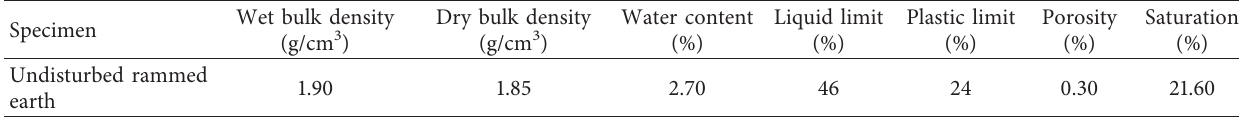
Table 3: Physical and mechanical indexes of undisturbed rammed earth (mean).